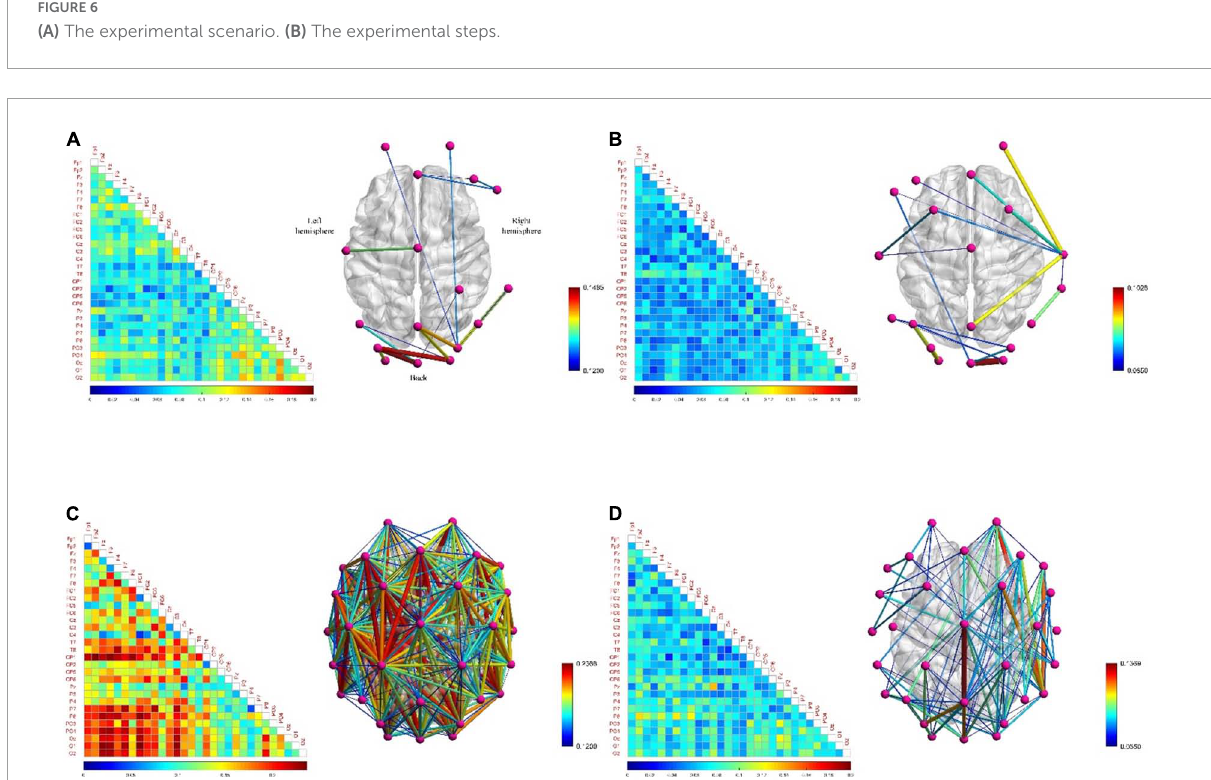
FIGURE7 The functional brain networks and connectivity matrices in resting and fatigued states. The perspective of the brain network map is a top view, with the left hemisphere of the brain on the left, and the occipital lobe area below. The lower limit of the connection threshold is manually adjusted to better display the characteristics, and the upper limit is the highest value of the network connection strength. The matrix diagram shows the lower triangular area of 30 channels, where the channels are arranged from top to bottom in order from the front (frontal lobe) to the back (occipital lobe) in the brain area, the same below. (A) Represents the situation when the electroencephalogram (EEG) is at low frequency in the resting state. (B) Represents the situation when the EEG is at high frequency in the resting state. (C) Represents the situation when the EEG is at low frequency in the fatigue state. (D) Represents the situation when the EEG is at high frequency in the fatigue